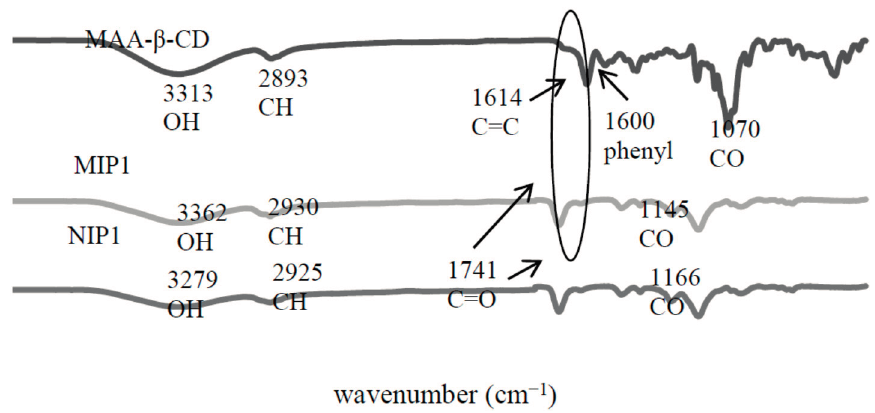
Figure 5. FTIR spectra of molecularly imprinted polymer-methacrylic acid functionalized β -cyclodextrin (MIP1) and non-molecularly imprinted polymer-methacrylic acid functionalized β -cyclodextrin